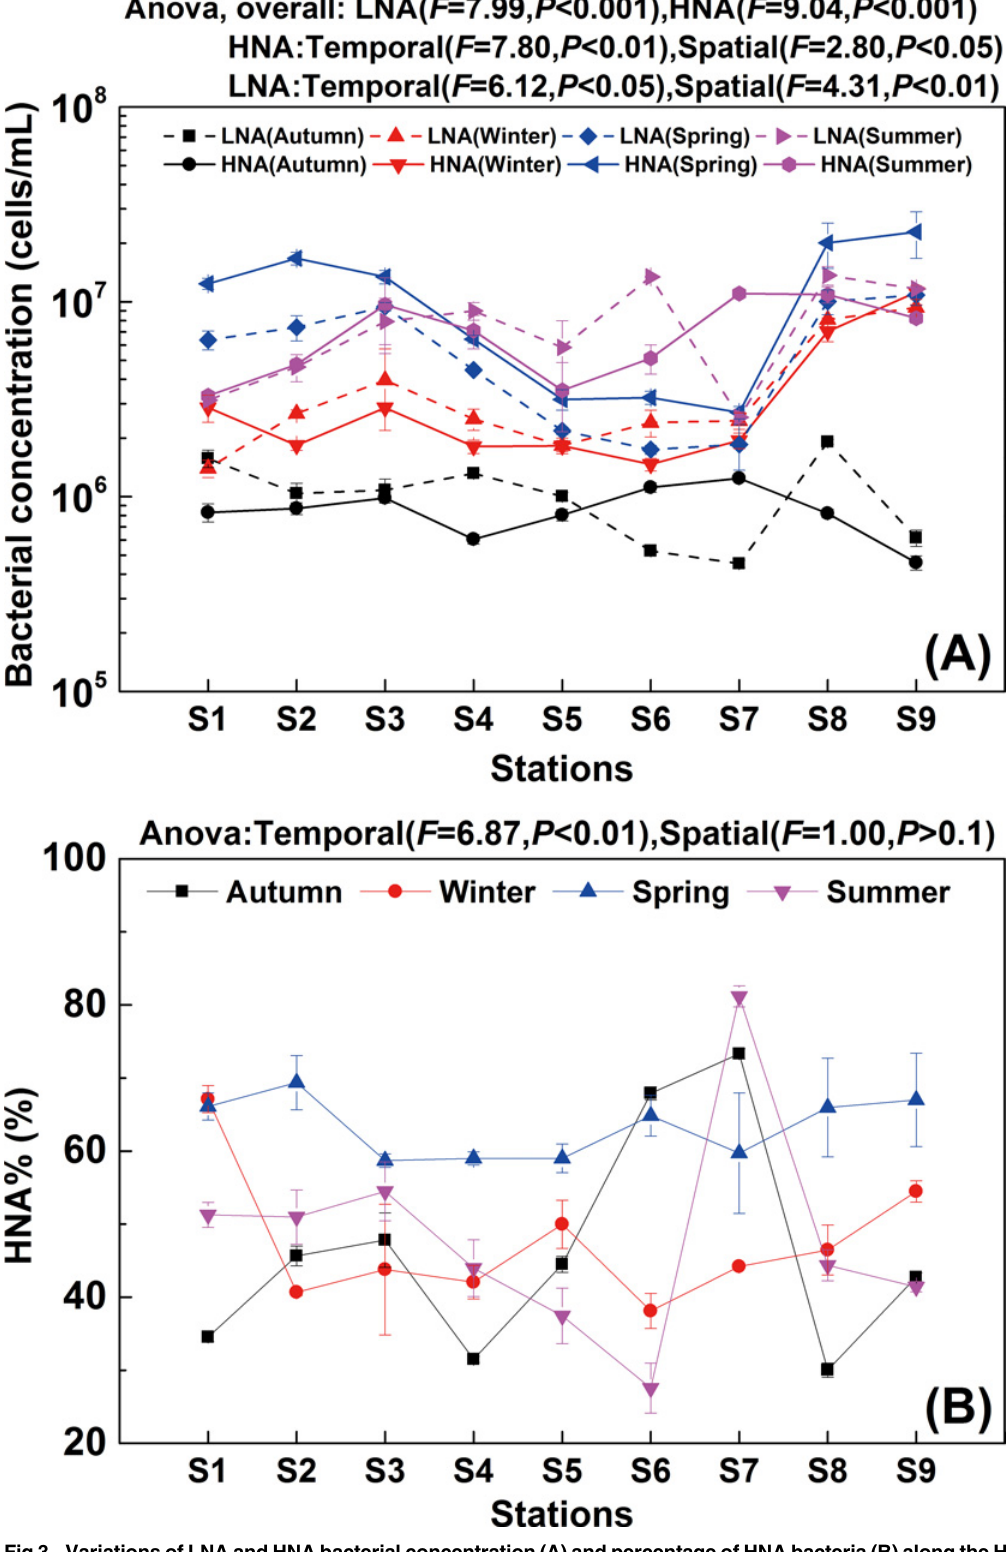
Fig 3. Variations of LNA and HNA bacterial concentration (A) and percentage of HNA bacteria (B) along the Haihe River. Error bars represent standard deviation of triplicate measurements. doi:10.1371/journal.pone.0153678.g003 PLOS ONE | DOI:10.1371/journal.pone.0153678 April 15,